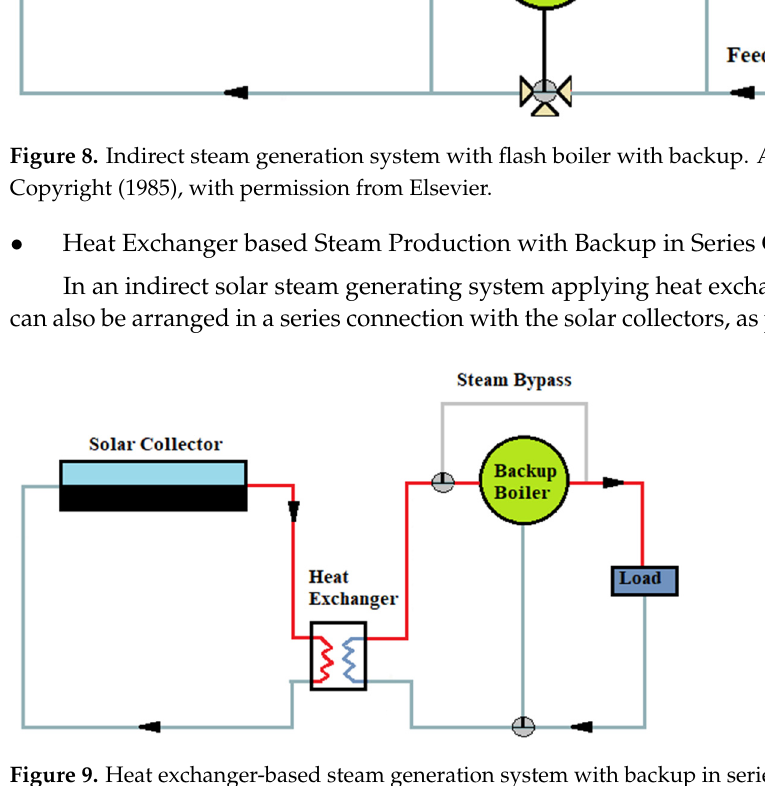
Figure 9. Heat exchanger-based steam generation system with backup in series connection. Adapted from Ref. [44], Copyright (1985), with permission from Elsevier.